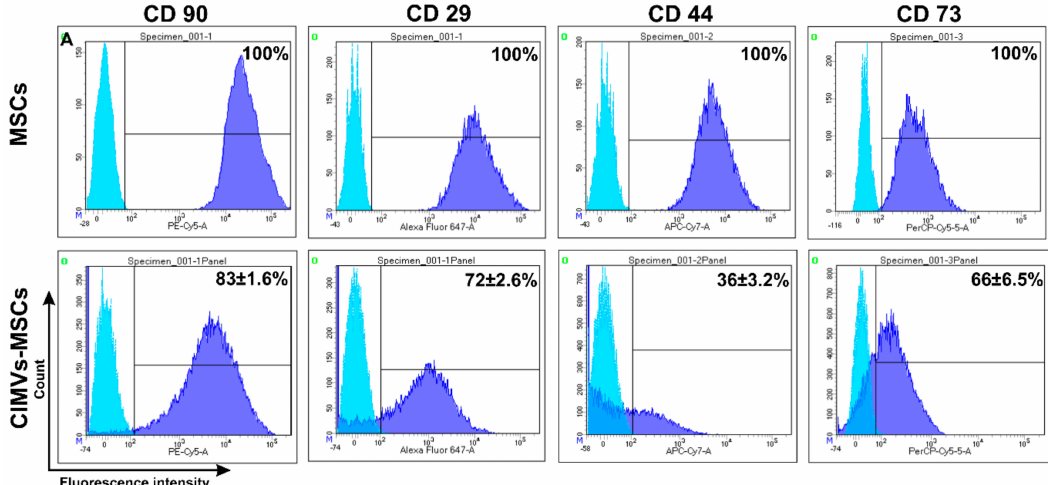
Figure 4. Immune phenotype of human MSCs and CIMVs-MSCs. MSCs and CIMVs-MSCs were stained with anti-CD90, anti-CD29, anti-CD44, and anti-CD73 monoclonal antibodies and analyzed using flow cytometer BD FACS Aria III (BD Bioscience, San Jose, CA, USA). Histograms were generated using the FACSDiva7 software (BDBioscience, Version 7.0, San Jose, CA, USA). Blue—isotype control; dark blue—MSCs or CIMVs-MSCs labeled with